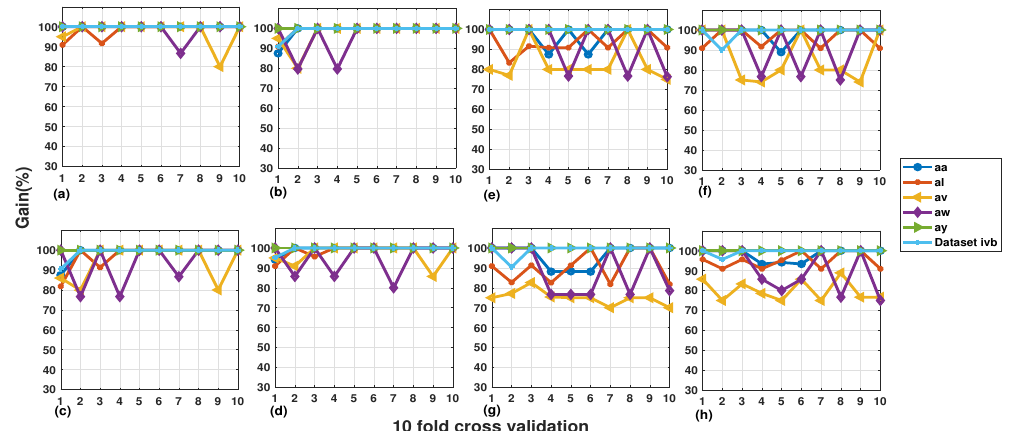
Figure 5. ( a – d ) 10-fold Sensitivity, Specificity, Kappa, F1-Score for FFNN Classifier. ( e – h ) Ten-fold Sensitivity, Specificity, Kappa, and F1-Score for SVM